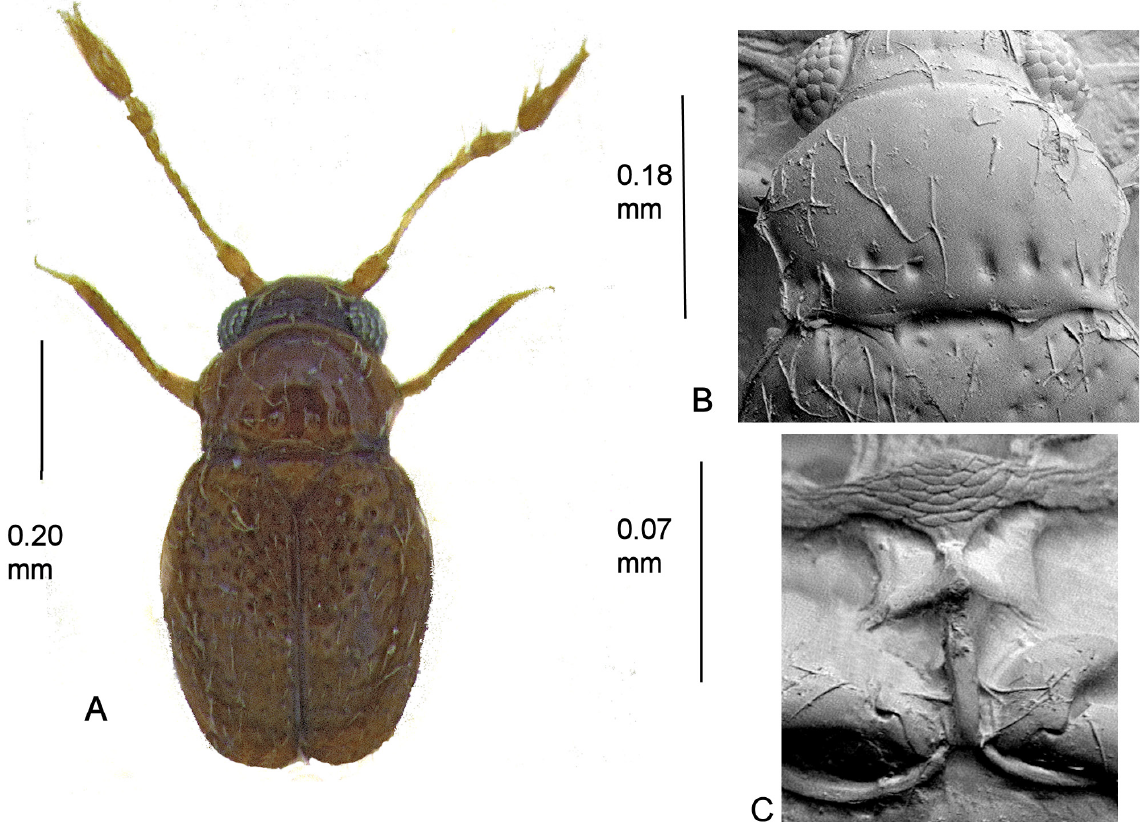
Fig. 41 . Cissidium robustum sp. nov. A . Habitus. B . Pronotum, × 470. C . Mesoventrite showing median process of collar, mid-keel and keel,